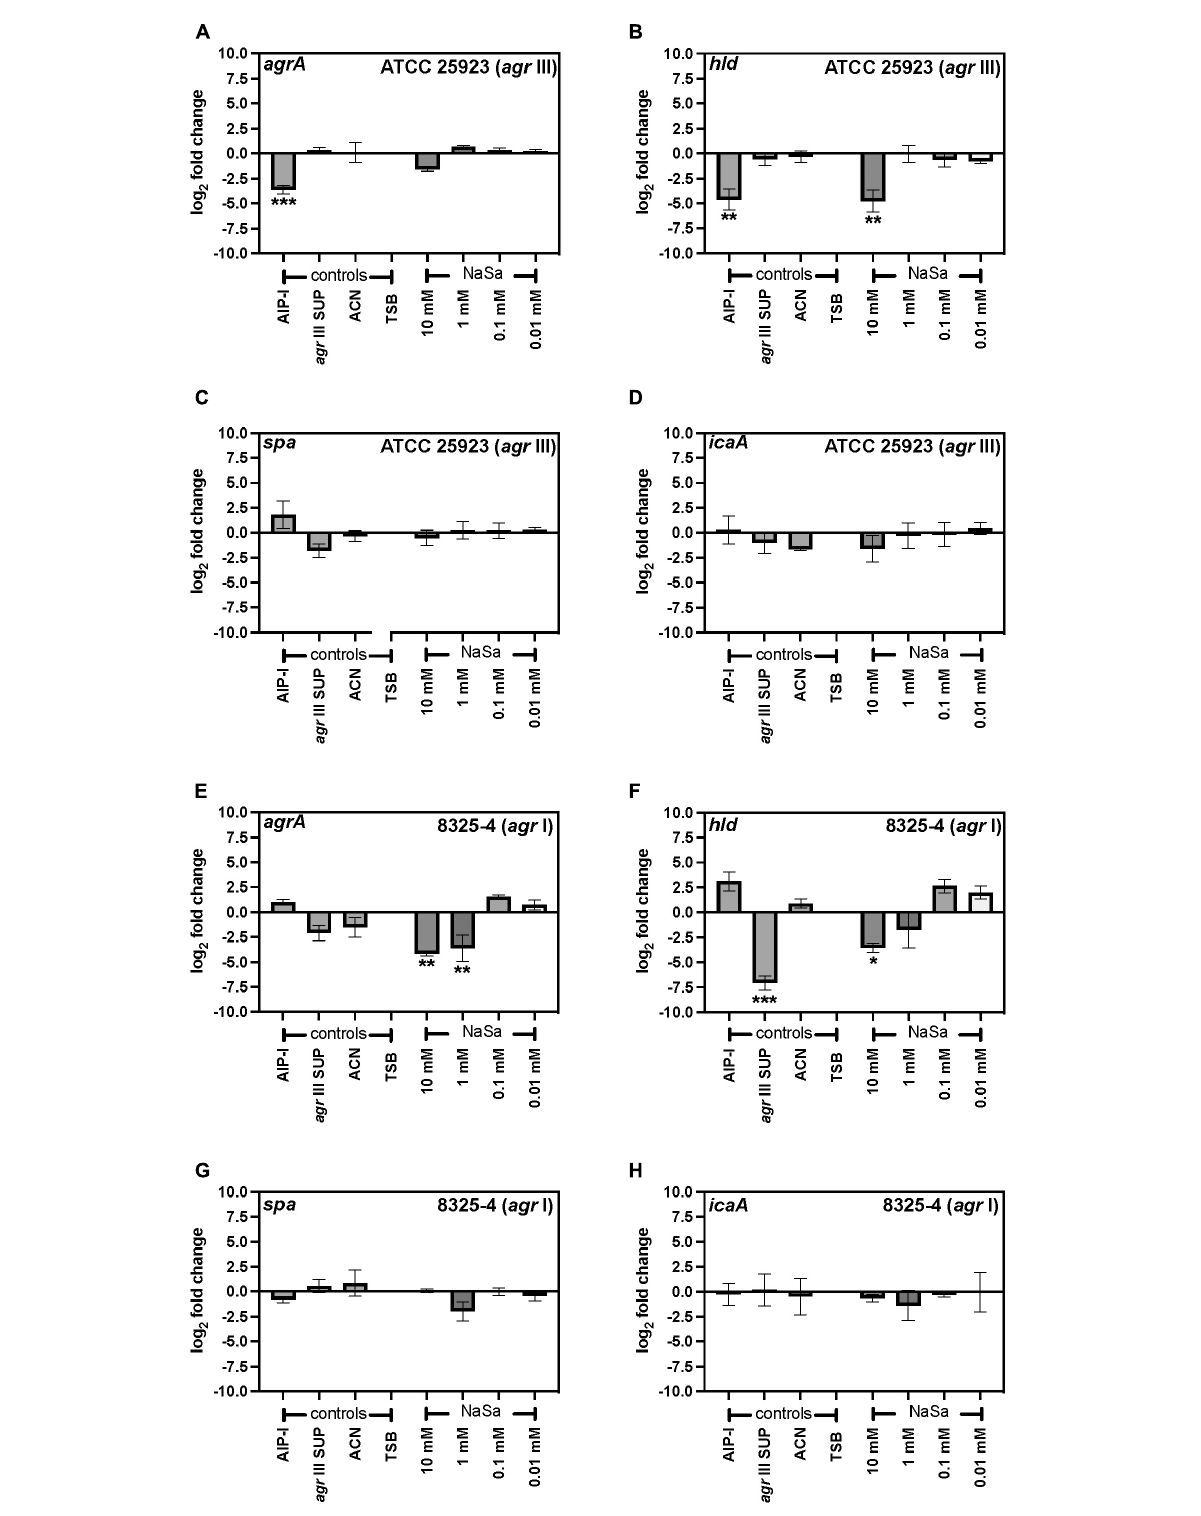
FIGURE2 NaSa inhibits the expression of agrA and hld, but not spa and icaA, at the mRNA level. Gene expression was assessed using ddPCR assays of agrA (A,E) , hld (B,F) , spa (C,G), and icaA (D,H) in S. aureus ATCC 25923 (A–D) and 8325-4 wild-type (E–H) . gyrA was used as a reference gene. Data represent the means from three independent experiments ± SD . * P ≤ 0.05, ** P ≤ 0.01, *** P ≤ 0.001, statistically significant to TSB (Tryptic Soy Broth) as media using one-way ANOVA Dunnett’s test. AIP-I, Autoinducing Peptide-I; SUP, supernatant; ACN, acetonitrile, used as AIP-I diluent